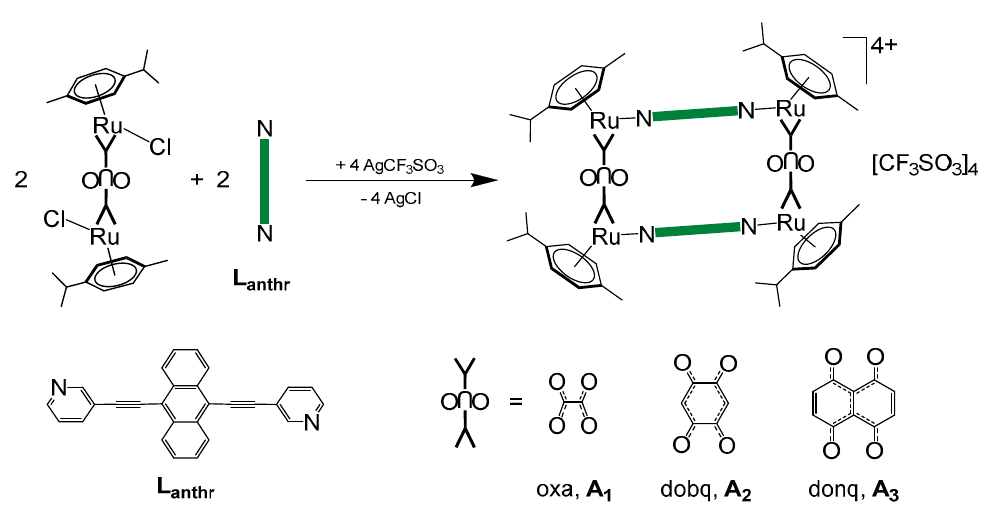
Figure 2. Ortep drawing of L anthr at 50% probability level ellipsoids.